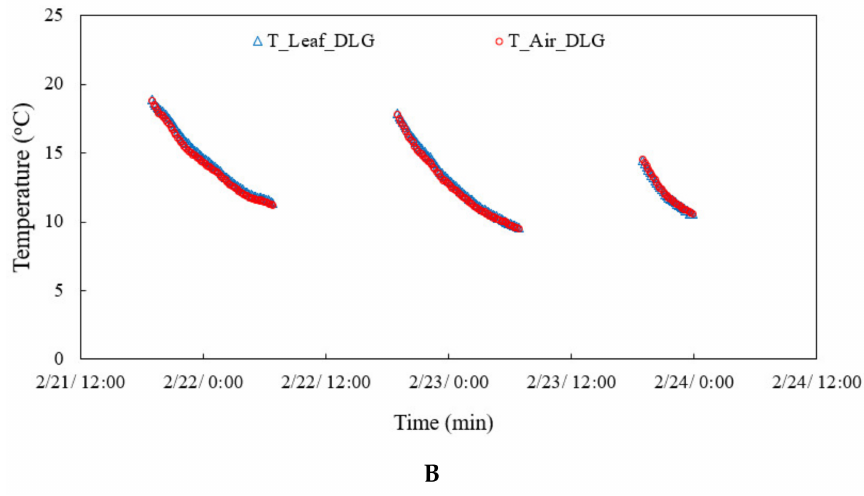
Figure 7. Leaf air temperature interaction ( A ) during the day and ( B ) during the night in SLG and DLG.